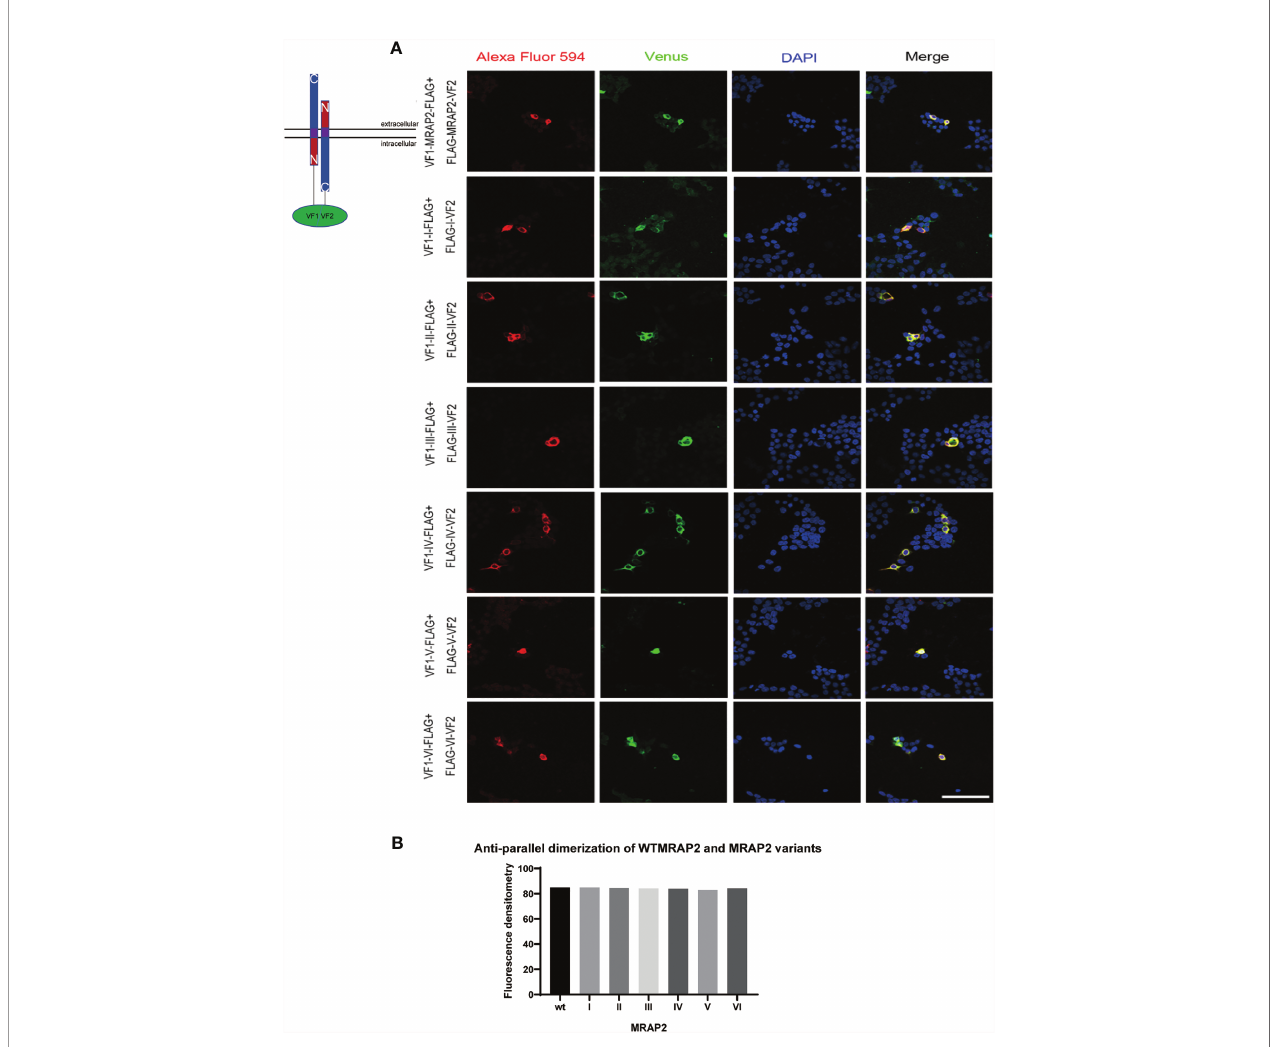
FIGURE 6 | Antiparallel dimerization of melanocortin receptor accessory protein 2 (MRAP2) and the MRAP2 variants. (A) HEK293T cells transfected with plasmid constructs containing Venus fragments on opposite sides of MRAP2 or the MRAP2 variants. Alexa Fluor 594 ( red ) indicated the fl uorescent secondary antibody. Venus fl uorescence ( green ) indicated the MRAP2 antiparallel homodimers. Nuclei stained with DAPI are shown in blue . All three channels were merged in the last photo of the panel . Scale bar , 50 m m. (B) Fluorescence densitometry analysis on the images in (A) . Each data column represents the mean ± SEM of three replicates ( N =